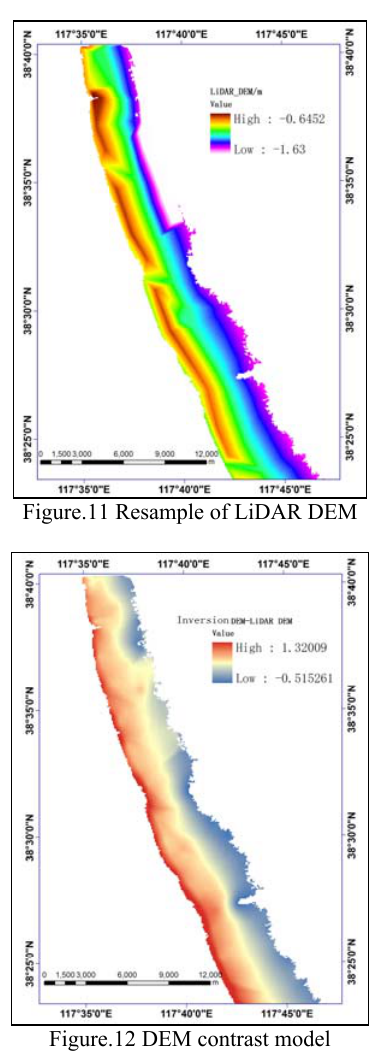
As showed in the statistics histogram of the subtract value (Figure.13), the error of the inversion DEM elevation distributed between -52cm and 132cm, concentrated in -12cm and 92cm. The mean error was 23cm, and the overall error was partial to positive, the root mean square (RMS) value was 35cm.